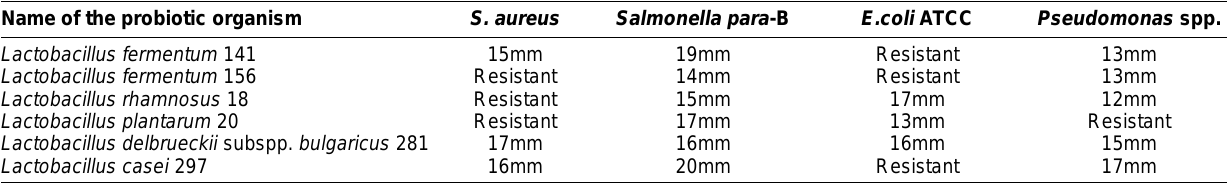
Antibiotic sensitivity test: Among six Lactobacillus